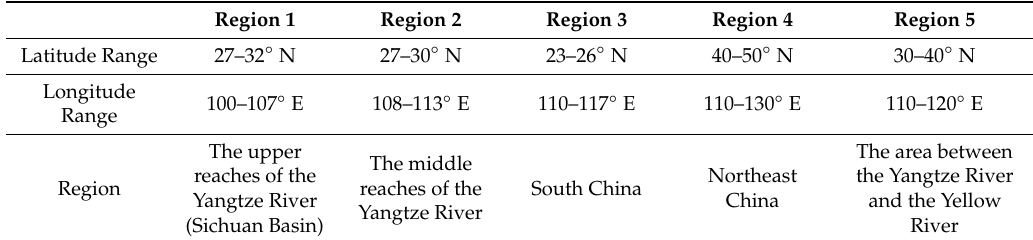
Table 1. The information of five regions in eastern